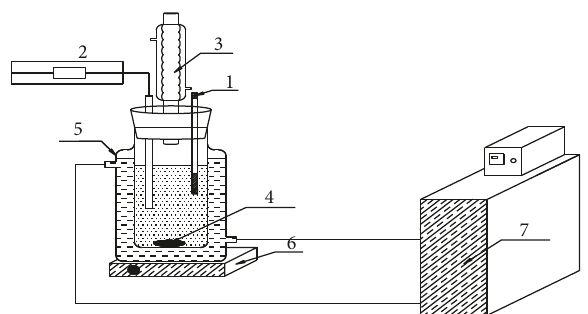
Figure 1: Apparatus used for the isothermal dissolution equilib- rium: (1) sampler; (2) thermometer; (3) condenser; (4) magnetic stirring rod; (5) jacketed glass cell; (6) magnetic stirrer; and (7) temperature-controlled water